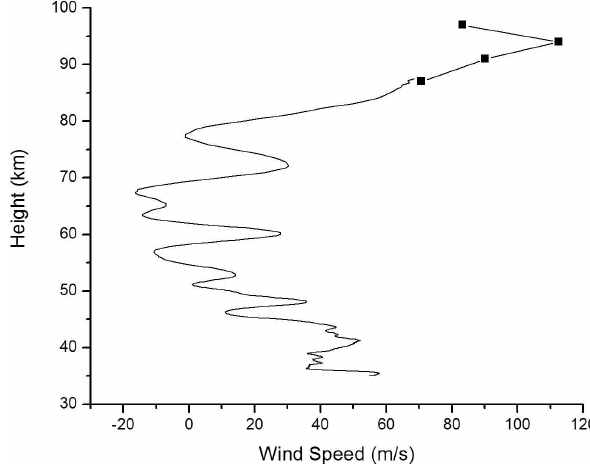
Fig. 19. Map of small-scale (ripple) event observed on 30/31 Janaury for the OH (left) and Na (right) emissions. The OH pattern exhibited a larger horizontal wavelength (14 km) as compared to the Na data (10 km) and was more extensive.